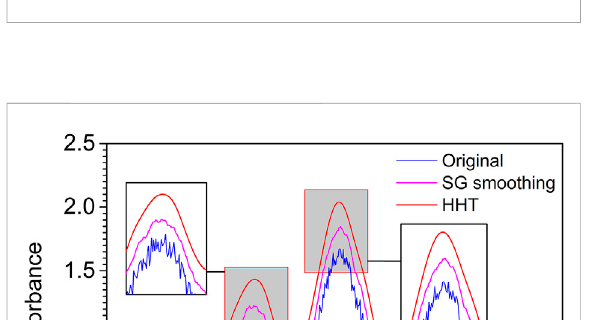
FIGURE 6 Mean and standard deviation of instantaneous frequencies for arti fi cially chemical noised signal.